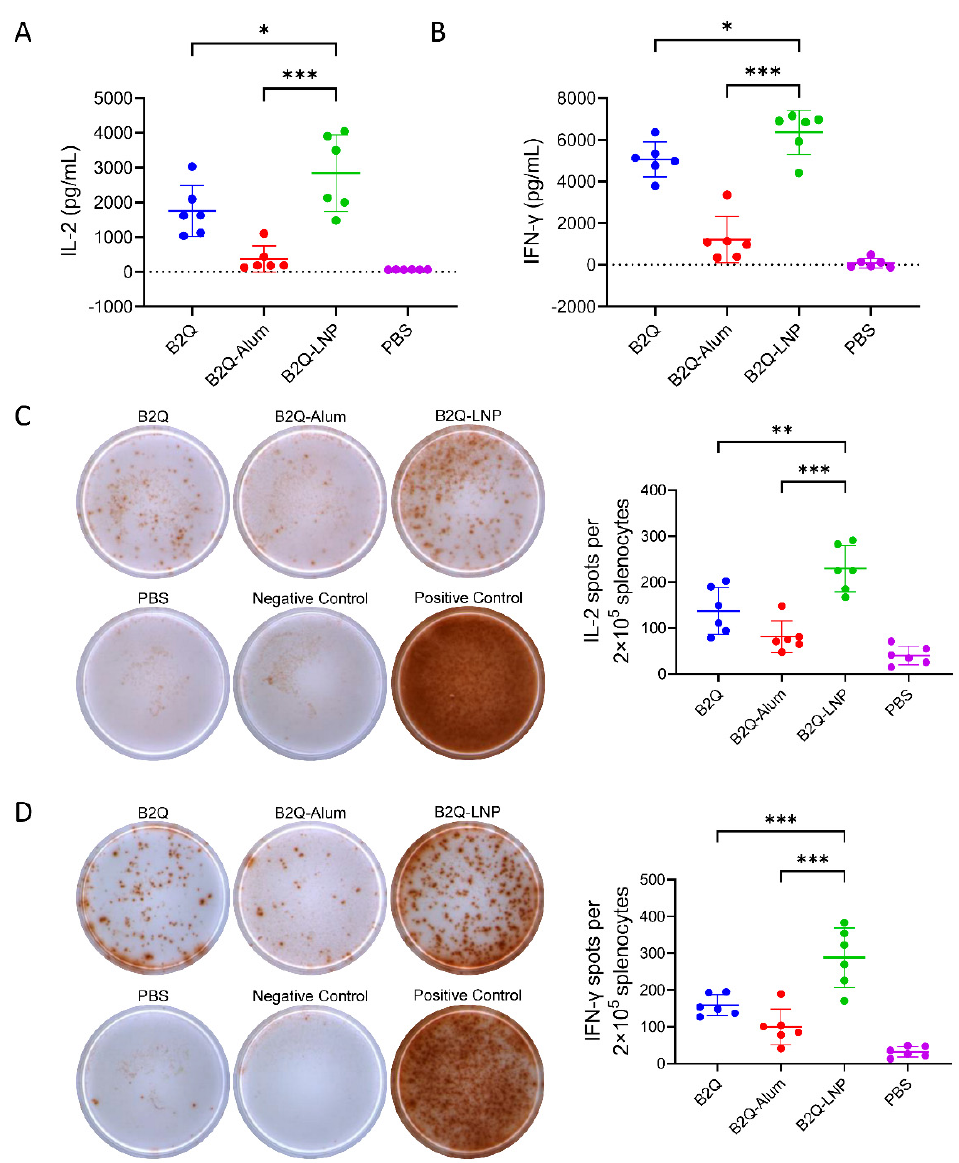
Figure 6. ELISA and ELISPOT analyses performed with splenocytes isolated from immunized mice in the LNP encapsulation study. The concentrations of IL-2 ( A ) and IFN- γ ( B ) secreted by splenocytes upon stimulation with 10 µ g/mL protein gE were measured by ELISA. ( C ) IL-2- and ( D ) IFN- γ -producing splenocytes (per 2 × 10 5 cells) induced by stimulation with 20 µg/mL protein gE were detected by ELISPOT. Images displaying representative results near the average value are presented in the left panel. Cells treated with the same volume of medium or PMA+ionomycin were used as the negative control and positive control, respectively. N = 6, points represent individual mice. Data are shown as the mean and SD and were analyzed by ANOVA, with the mean of the B2Q-LNP group used as a control. * p ≤ 0.05; ** p ≤ 0.01; *** p ≤ 0.001.